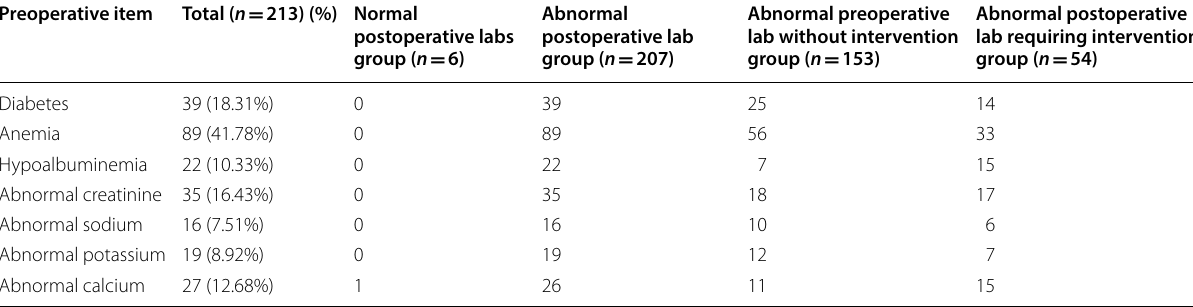
Table 2 Abnormal preoperative laboratory tests in different patient